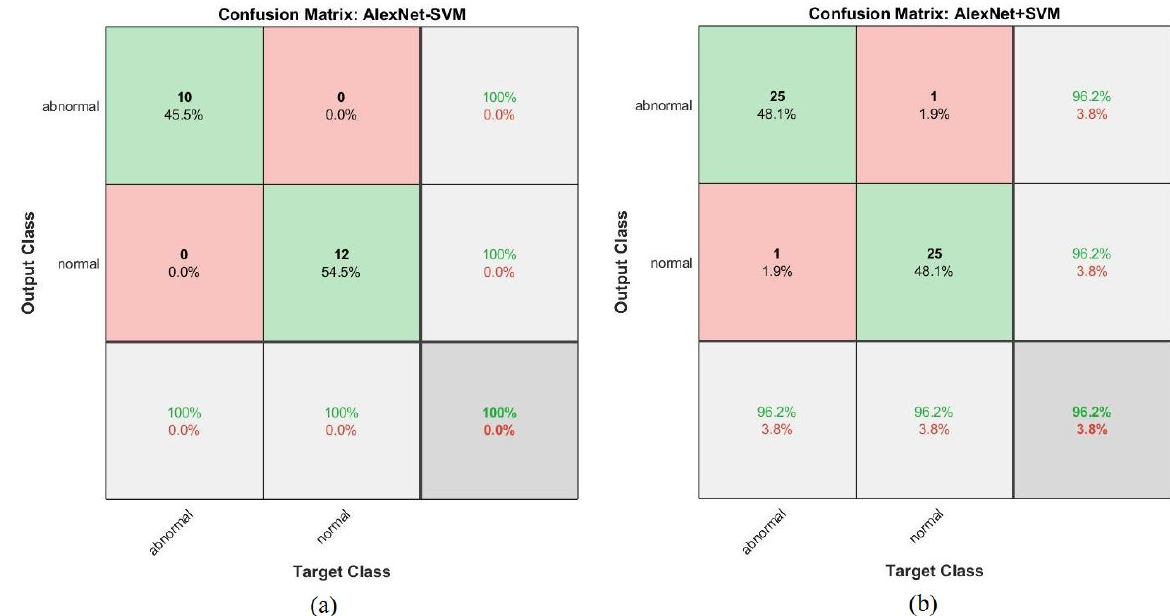
Figure 26. Confusion matrix for the AlexNet + SVM hybrid technique for the ( a ) ALL_IDB1 and ( b ) ALL_IDB2 datasets.